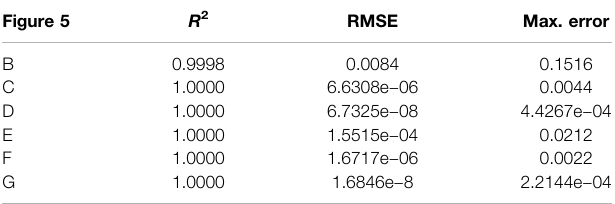
TABLE 3 | Error estimation for the interpolating surface in Figure 5 . Figure 5 R 2 RMSE Max. error